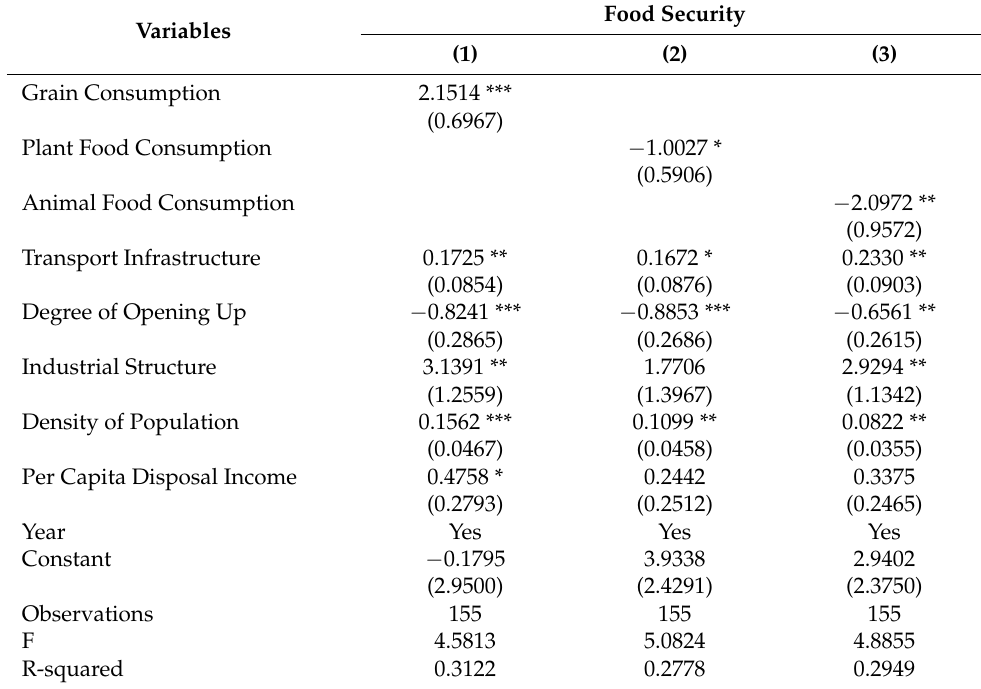
Table 5. Regression estimates the impact of food consumption structure on food